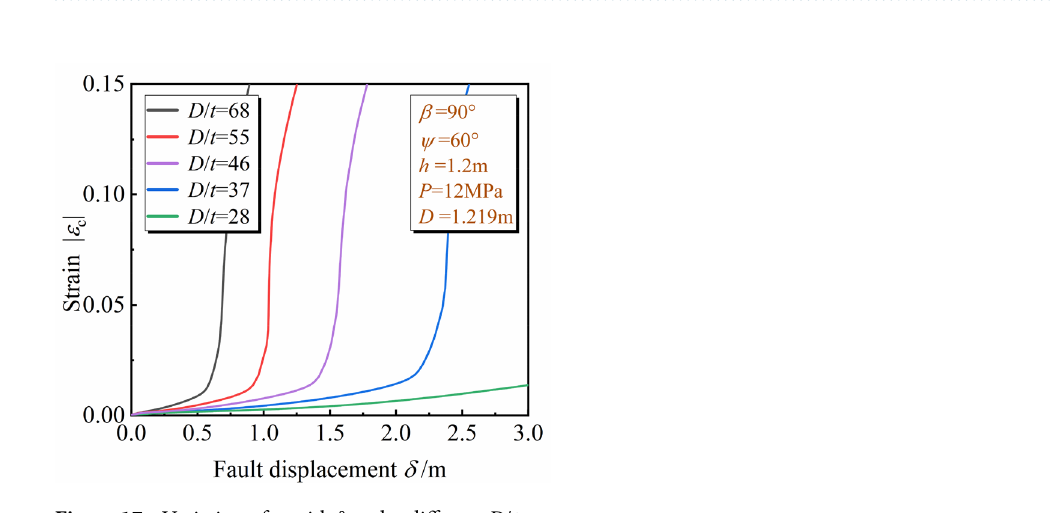
Figure 17. Variation of ε c with δ under different D /